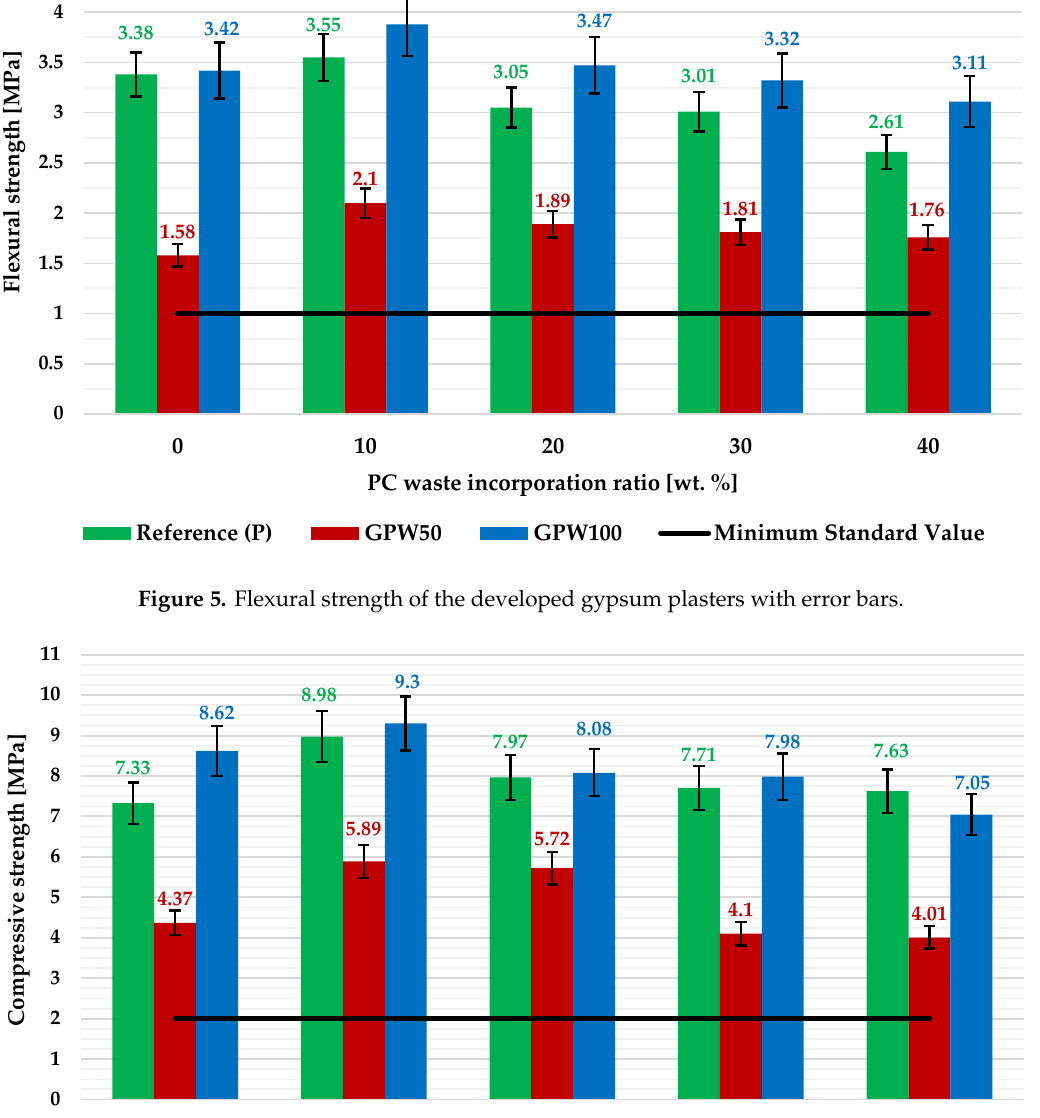
Figure 7. Thermal conductivity of the developed gypsum plasters.